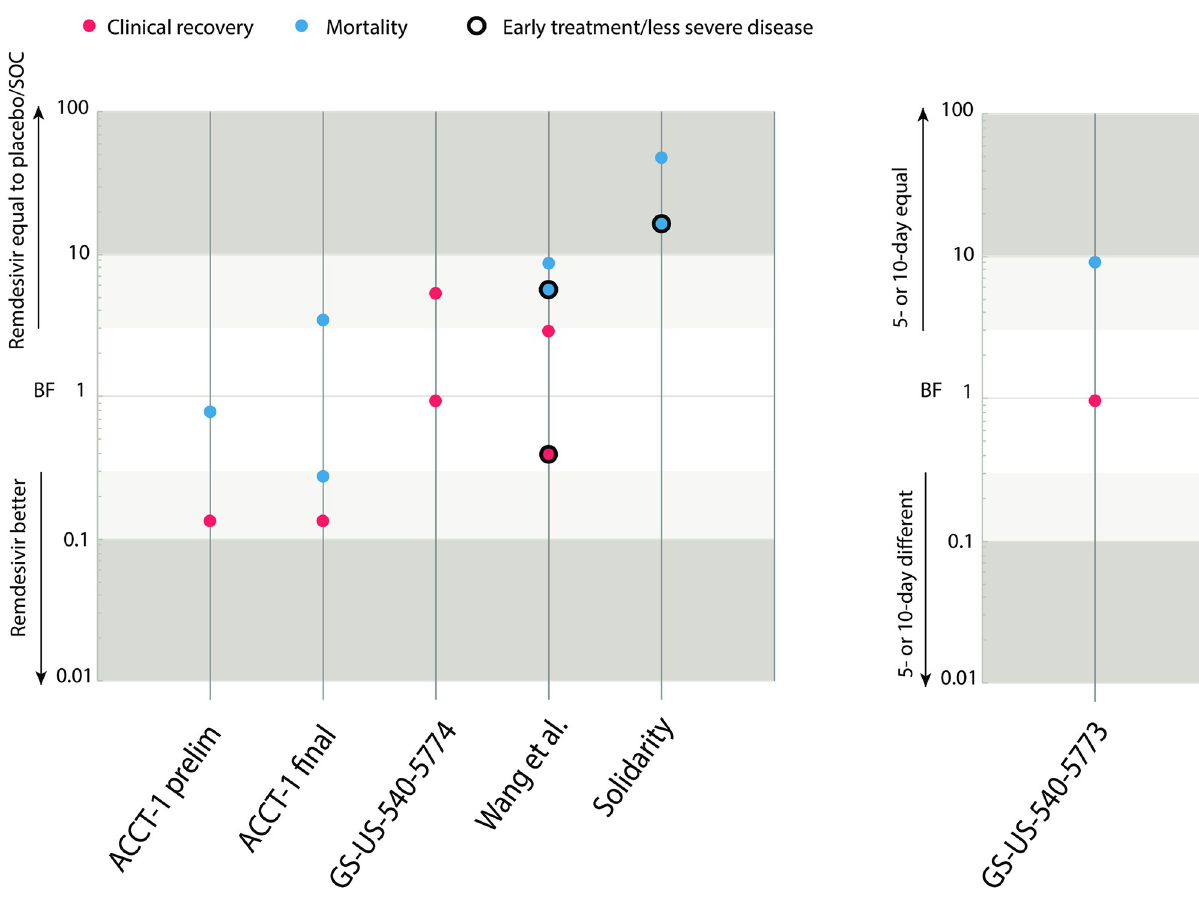
Fig 1. Bayesian reanalysis of clinical trials testing the efficacy of remdesivir against COVID-19. A BF 01 between 1/3 and 3 (white area) indicates ambiguous evidence, above 3 or below 1/3 (light grey area) moderate evidence, and above 10 or below 1/10 (dark grey area) strong evidence. A black circle either indicates treatment within 10 days of symptom onset (Wang et al.) or treatment on patients without mechanical ventilation (Solidarity). The GS-US-540-5773 trial did not compare remdesivir to placebo, but instead showed that there is no difference between a 5- or 10-day regimen of